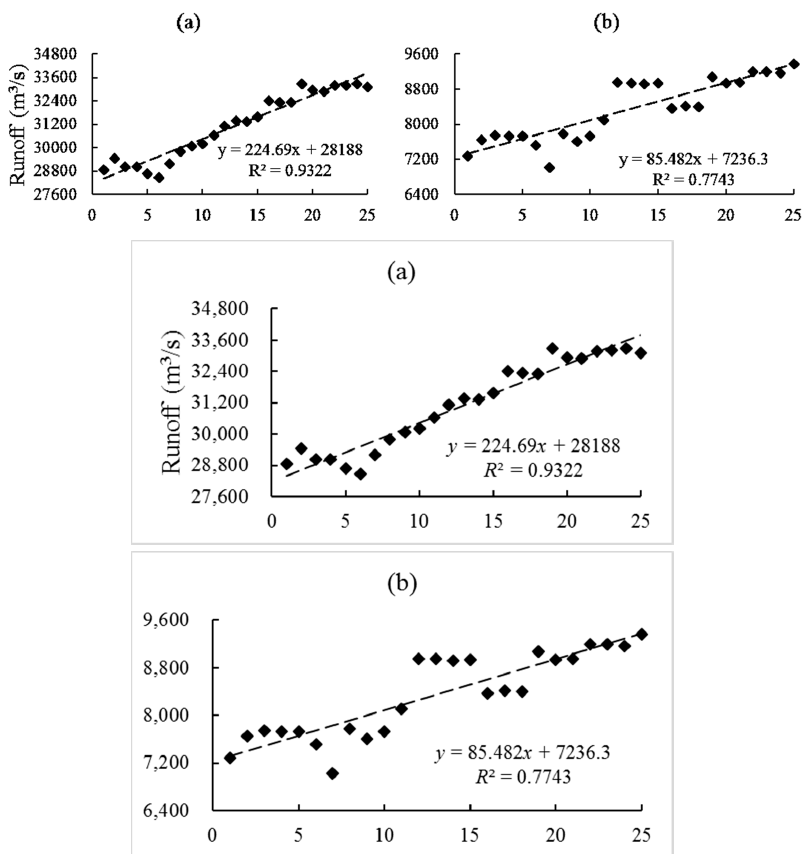
Figure 5. Trends in the first two moments of Wuzhou: ( a ) simple moving mean; ( b ) simple moving standard deviation.